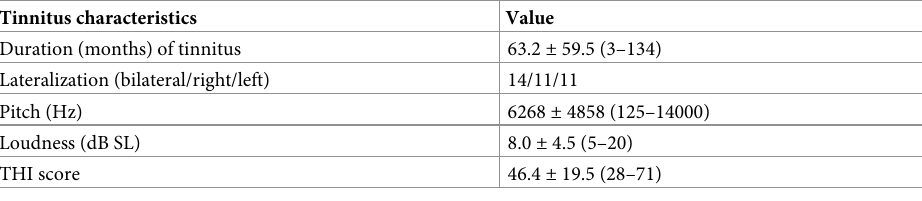
Table 1. Characteristics of tinnitus in 36